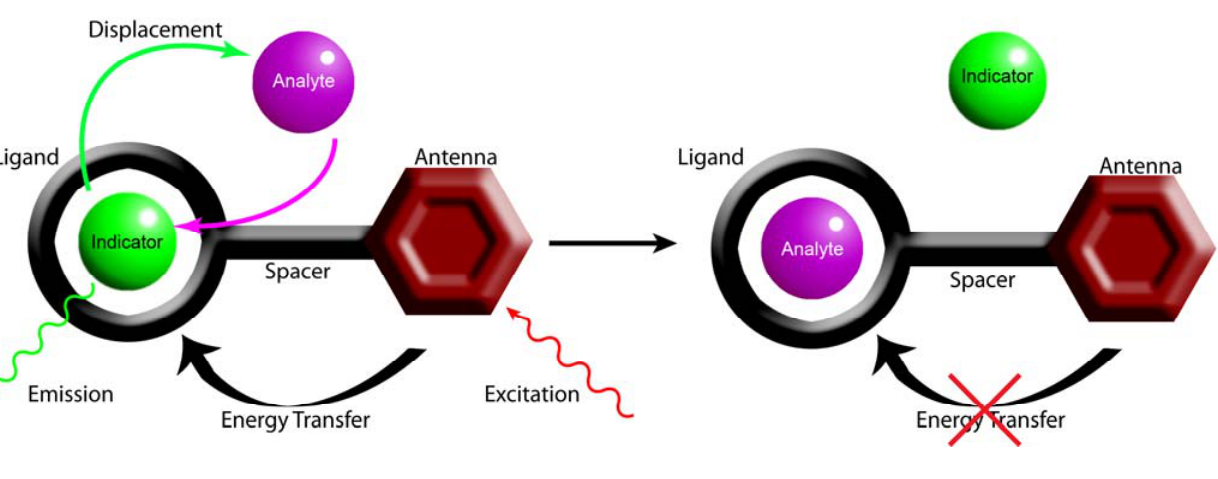
Figure 1. Cartoon representation of the Indicator Displace Assay (indicator = lanthanide, analyte = Fe 3+ antenna = N -Methyanthranyl